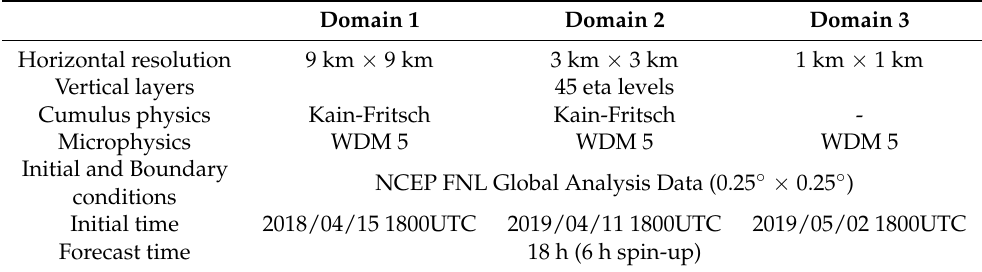
Table 3. Overview of the WRF model configuration.